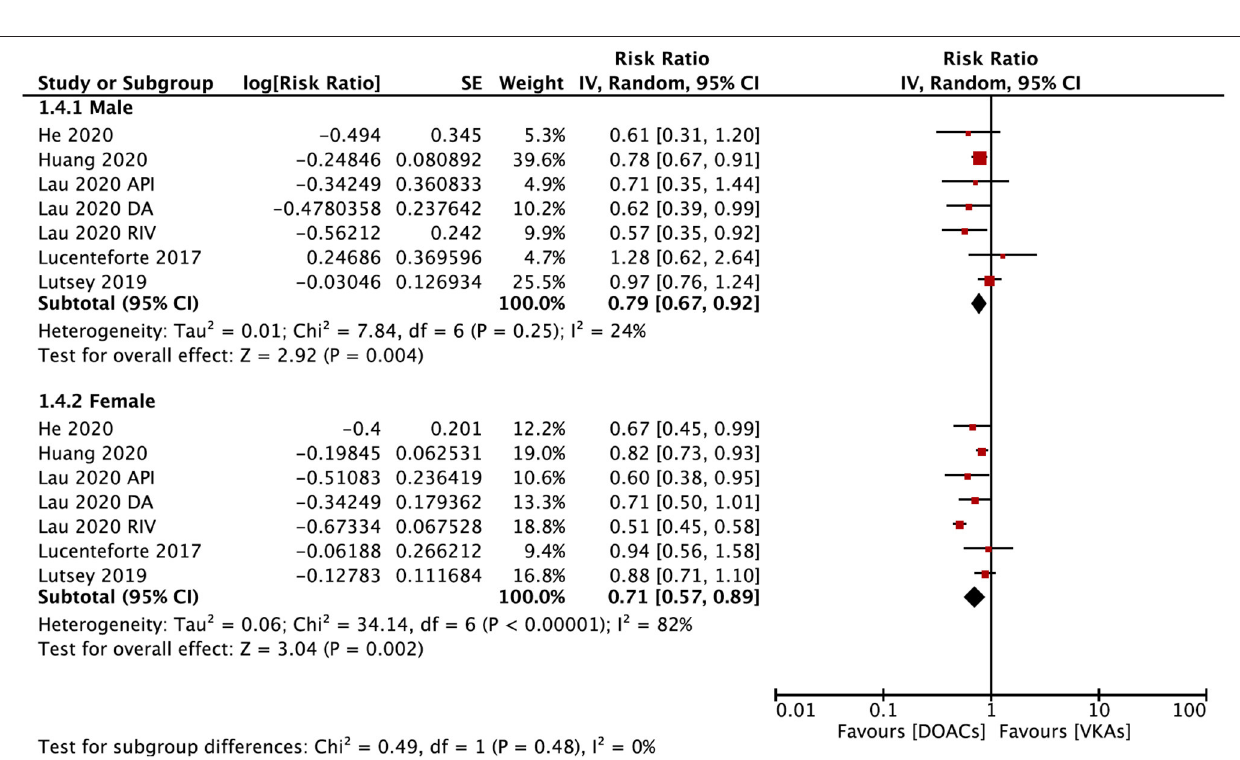
Frontiers in Cardiovascular Medicine |